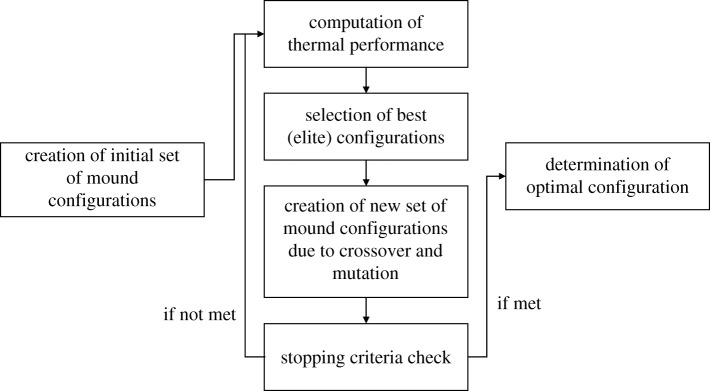
Flow chart of the genetic algorithm used in the optimization process.